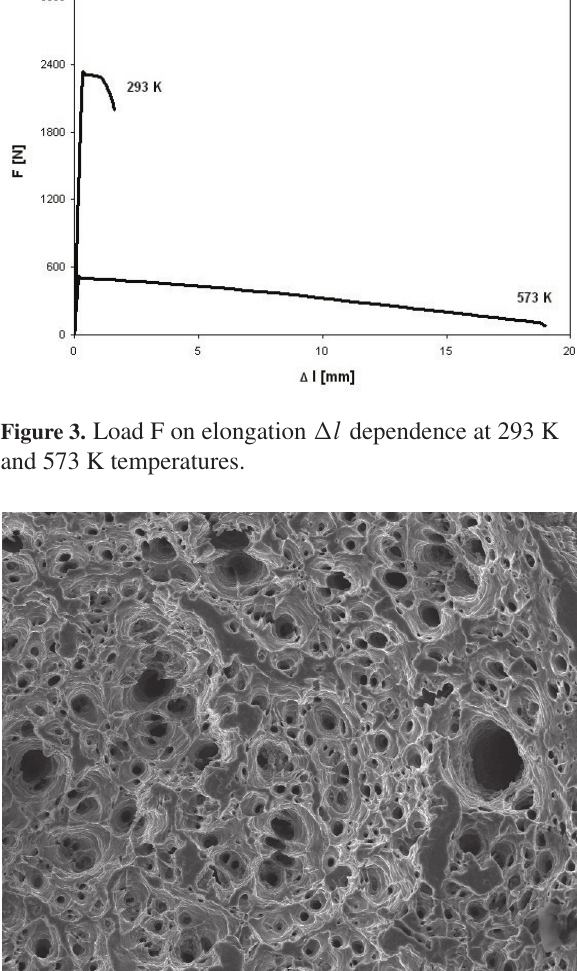
Figure 2. Tensile test piece before and after test.